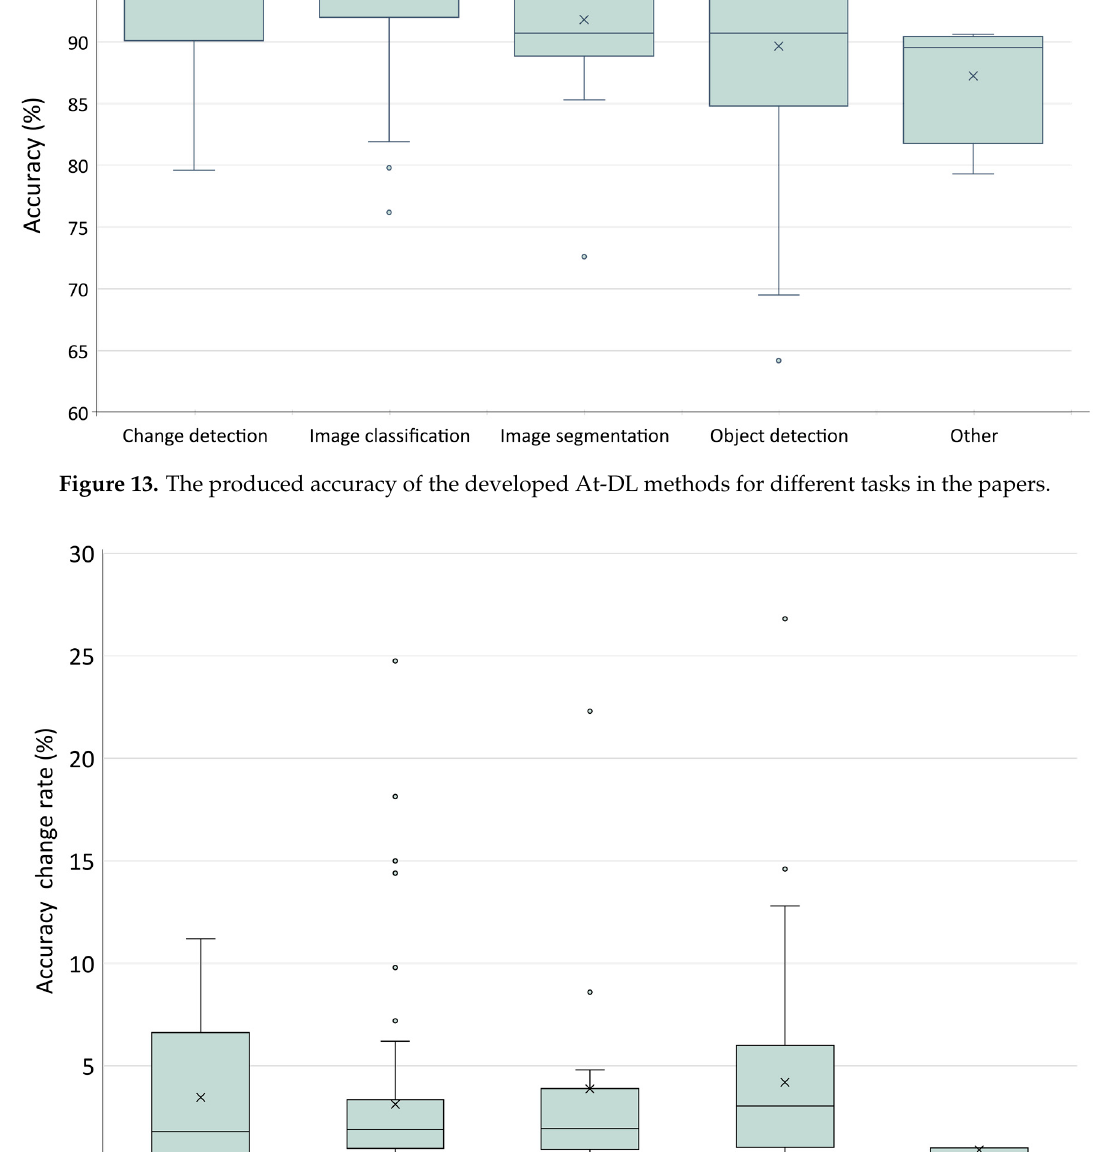
Remote Sens. 2021 , 13 , x FOR PEER REVIEW 16 of 23